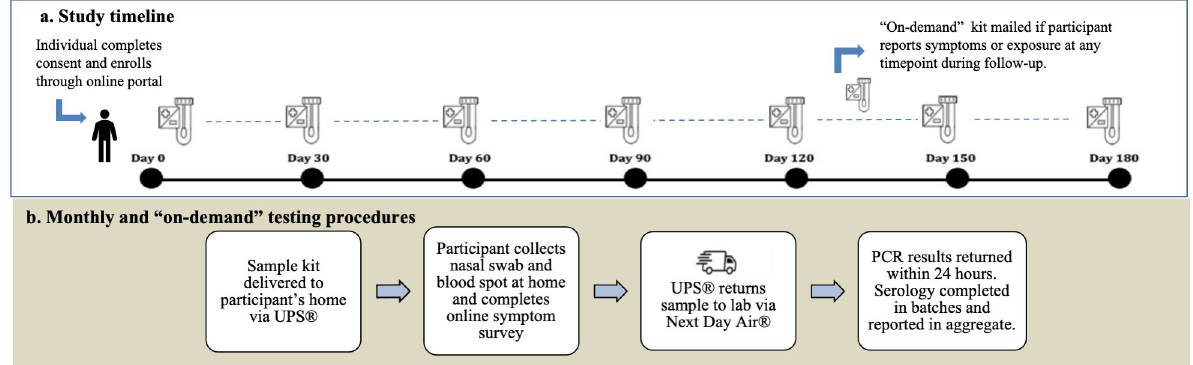
Fig 2. TestBoston procedures. The timeline for TestBoston participants (Part A) includes enrollment at time 0 and subsequent follow up for six calendar months. Routine monthly test kits are dispatched every 30 days, with the option to request “on-demand” kits at any timepoint if displaying symptoms consistent with COVID-19 or if exposed to COVID-19. Test kit procedures (Part B) include delivery, sample collection, return, and processing of test